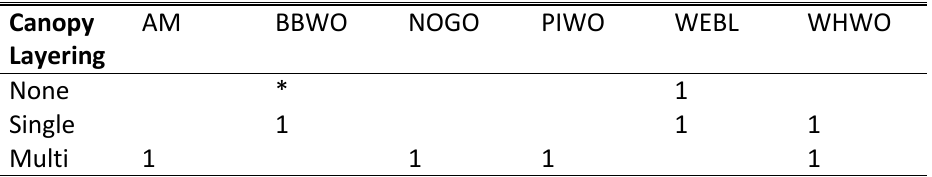
Table A8.4. Scores for species by stem size Size AM BBWO NOGO PIWO WEBL WHWO Barren